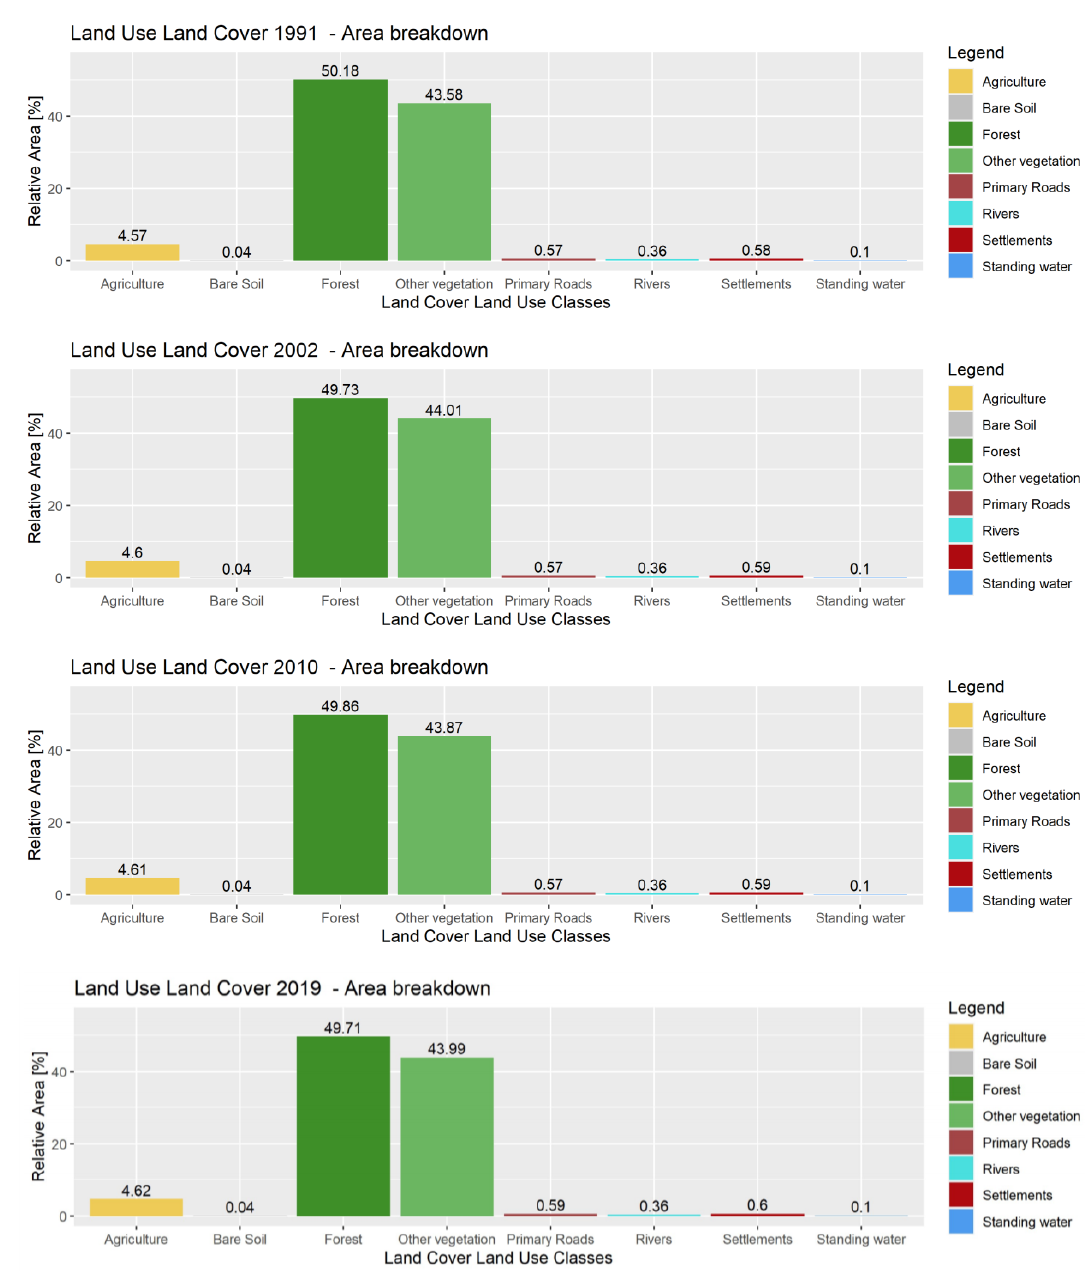
Figure 16. Breakdown of the area of land cover land use classes for the epochs 1991, 2002, 2010 and 2019.